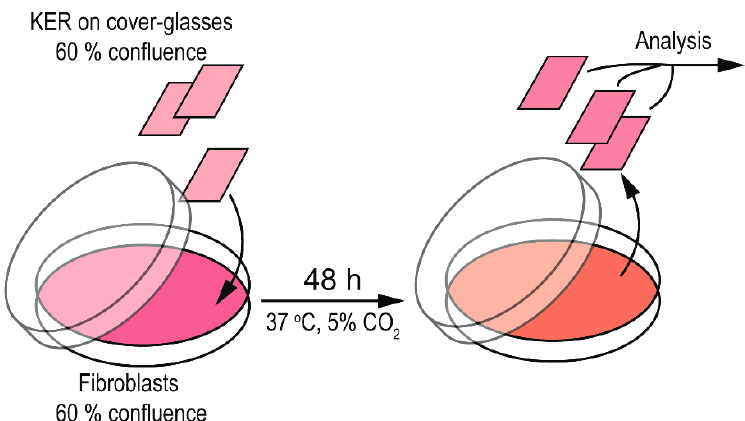
Figure 1. Contactless keratinocytes-fibroblasts co-incubation protocol. Keratinocytes (KER) were grown on cover-glasses (1.5 cm 2 ) until semi-confluence (generally for 24 h) and put in Petri dish (diameter 10 cm) with semi-confluent fibroblasts. After 48 h of co-incubation, the KER–containing cover-glasses were removed from the Petri dishes, KER were trypsinized and examined.